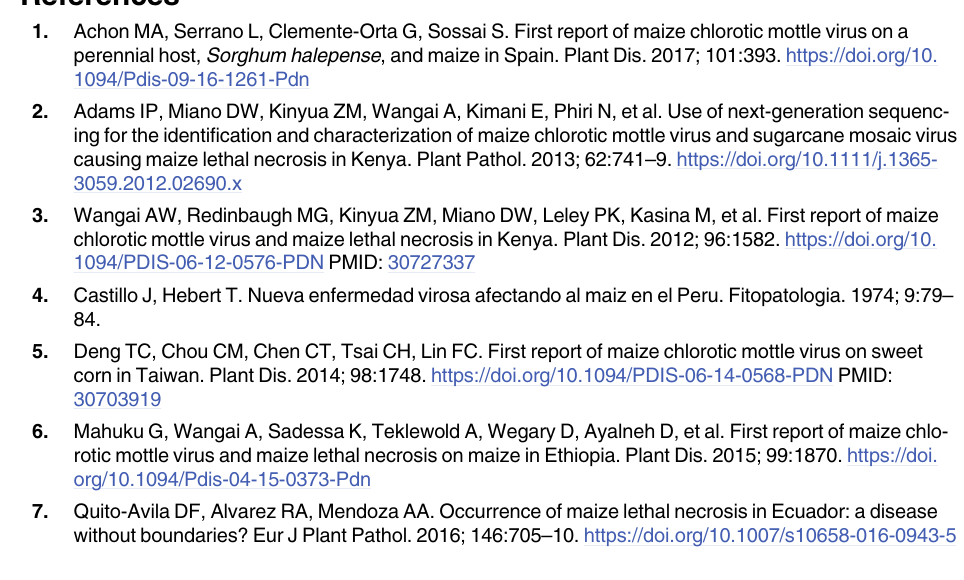
S3 Table. Transmissibility of maize chlorotic mottle virus (MCMV) from seed harvested from MCMV-HI infected plants at three maturity